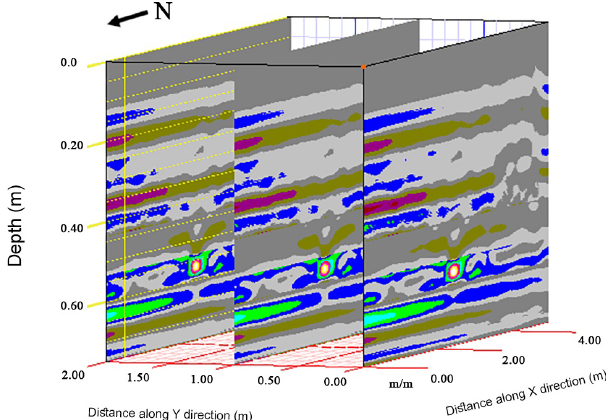
Figure 11. The multiple slices view along y direction at distance (0, 1 and 2m) determines the depth and extension of the pipe.